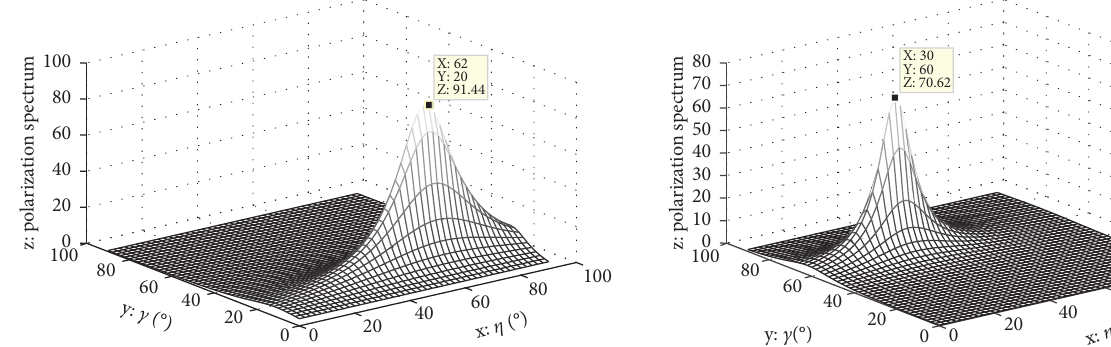
Figure 5: Polarization estimation with ( θ , ϕ ) � ( 30 ° , − 40 ° ) .